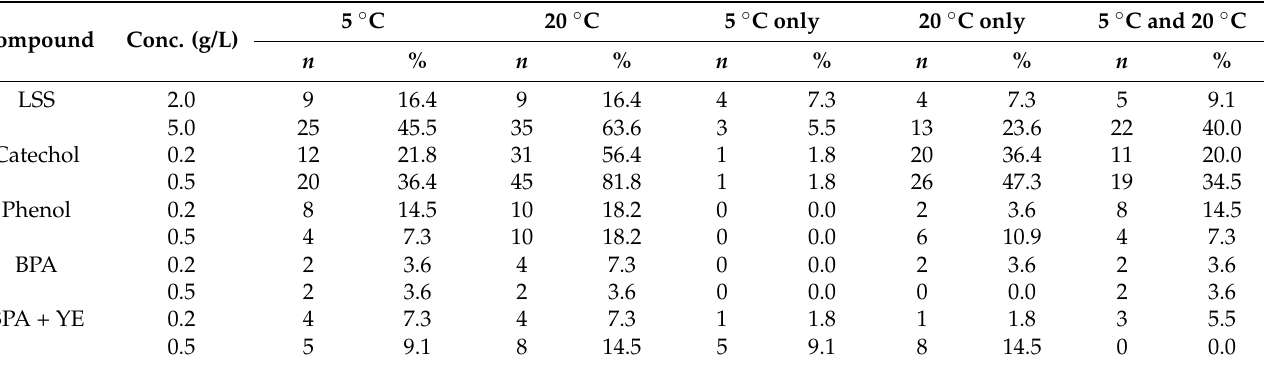
Table 2. Effect of temperature and concentration on the bacterial utilization of organic polymers as sole carbon source (100% = 55, LSS = lignin sulfonic acid; BPA = bisphenol A). Compound Conc.